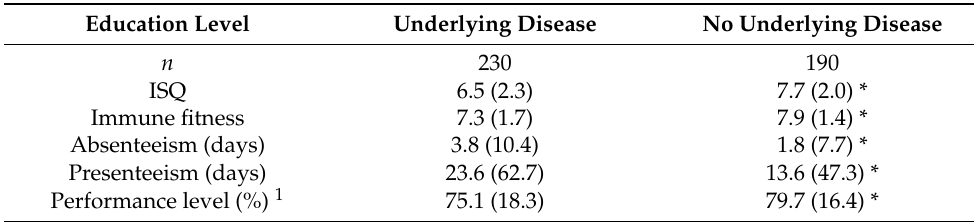
Table 6. Absenteeism, presenteeism, and work performance on days with reduced immune fitness according to underlying disease status.